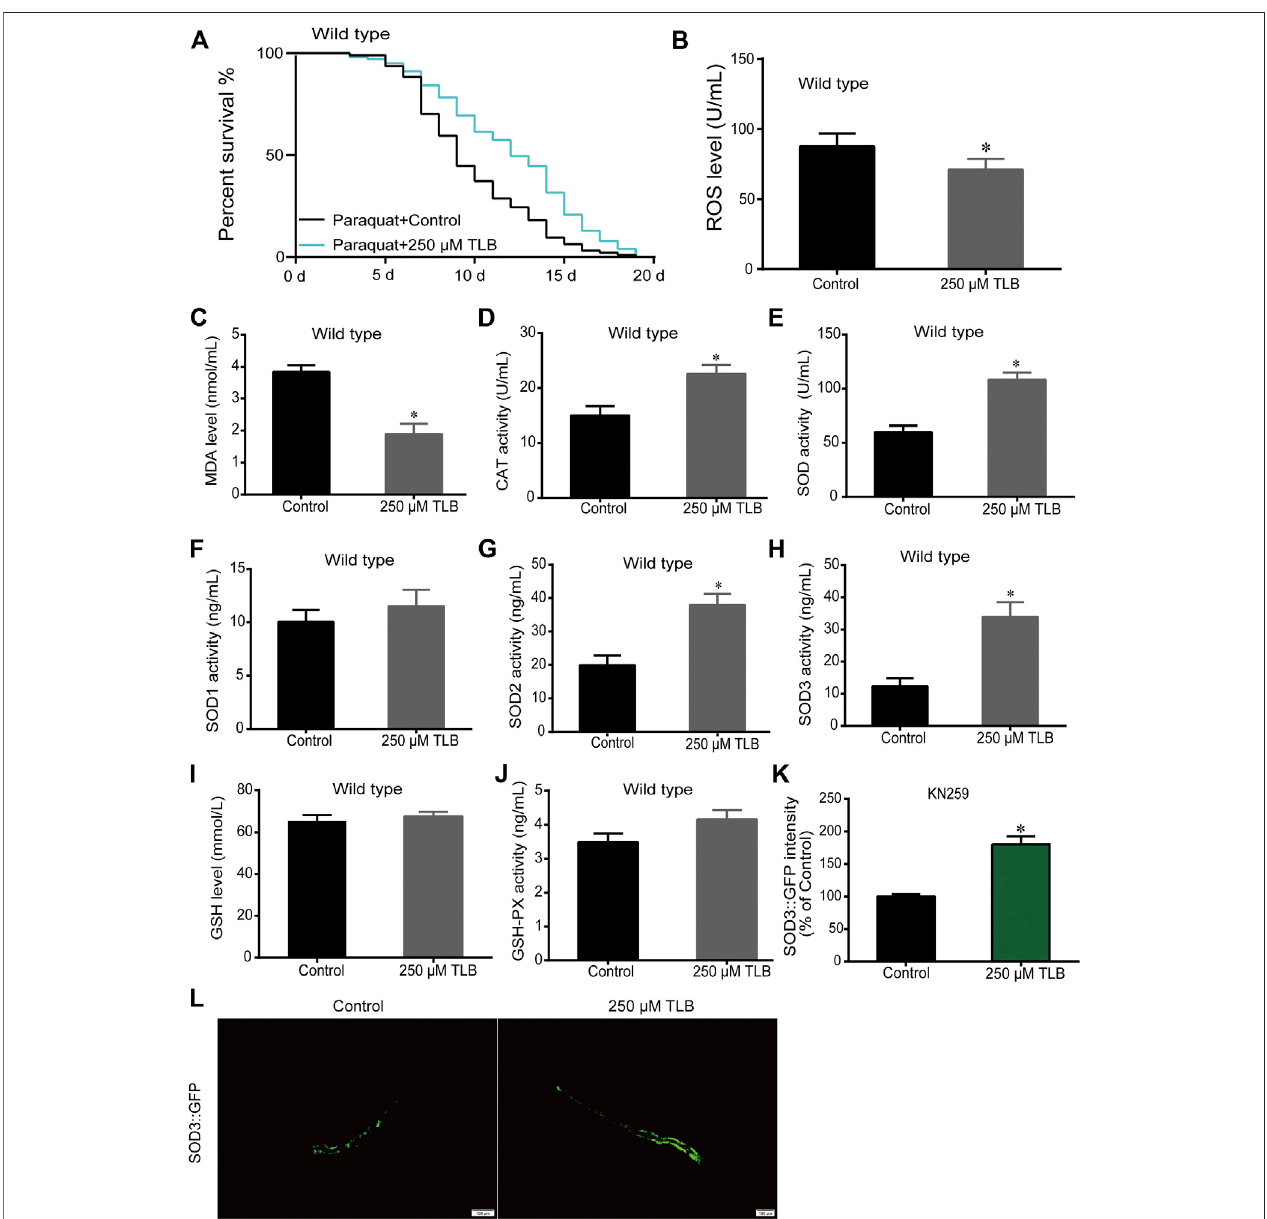
FIGURE4| TLBreinforcedtheoxidativestresstoleranceof C.elegans .Wildtype C.elegans weretreatedwithorwithoutTLBafterparaquatinsult. (A) TheKaplan- Meier survival curves after paraquat insult. Wild type C. elegans were treated with TLB ( n (cid:2) 93 – 101), and p values were calculated by the log-rank test. C. elegans were raised in the absence or presence of 250 μ M TLB for 72 h. The total protein of C. elegans was extracted and centrifuged for 10 min at 10,000 × g, 4 ° C, then the supernatant was detected using appropriate ELISA kits according to the manufacturer ’ s protocol. (B) ROS level ( n (cid:2) 1000); (C) MDA level ( n (cid:2) 1000); (D) CAT activity( n (cid:2) 1000); (E) SODactivity( n (cid:2) 1000); (F) SOD1activity( n (cid:2) 1000); (G) SOD2activity( n (cid:2) 1000); (H) SOD3activity( n (cid:2) 1000); (I) GSHlevel( n (cid:2) 1000); (J) GSH-Px activity( n (cid:2) 1000). (K) TheSOD3transgenic C.elegans wereraisedintheabsenceorpresenceof250 μ MTLBat20 ° Cfor72 h,andthe fl uorescenceof C.elegans were observed under a fl uorescence microscopy. (L) The mean pixel fl uorescence intensity of protein SOD3 were quanti fi ed using the Image Pro Plus 6.0 software ( n (cid:2) 20). Magni fi cation × 100; scale bar, 100 μ m. Data were presented as mean ± SEM. * p < 0.05 vs. non-TLB treated controls.